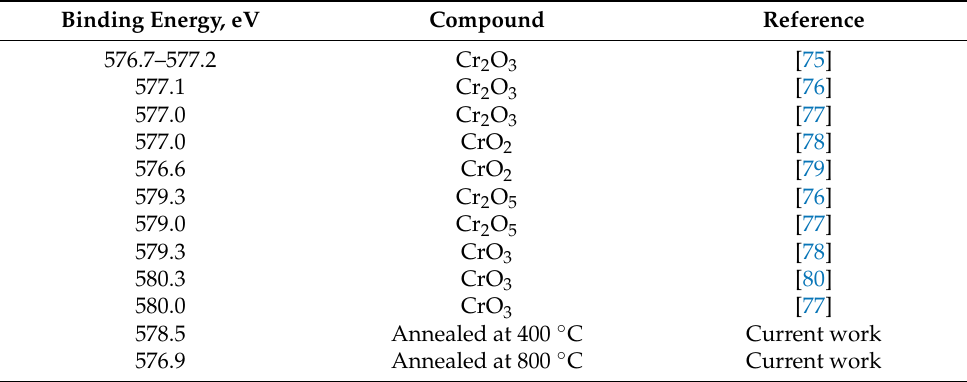
Table 1. A summary of 2p 3/2 binding energies in chromium oxides.